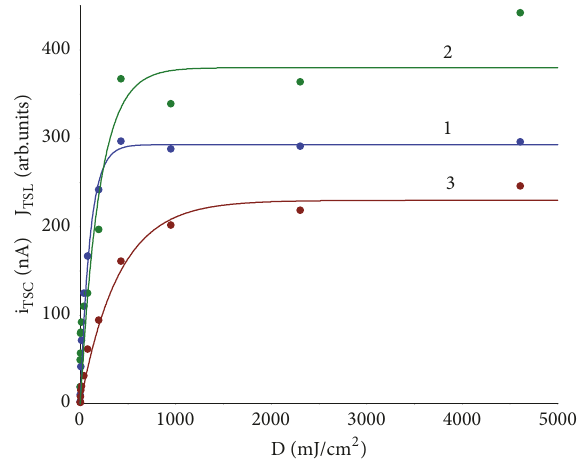
Figure 8: Dose dependencies of TSC (1) , TSL-630 (2) , and TSL-970 (3) peak 𝑇 m = 224 K of the ZnSe #2 sample at two X-ray excitation intensities (dots) and theoretical light sum accumulation curves (solid lines) by (10)